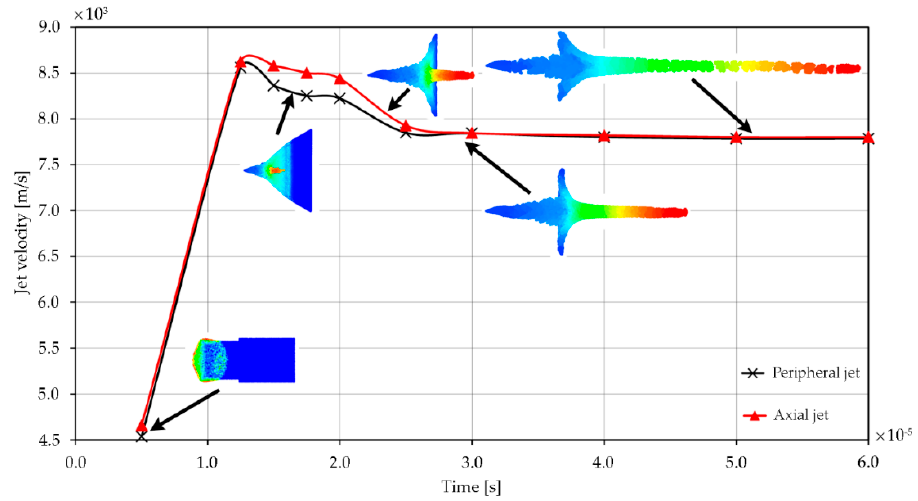
Figure 13. Jet velocities for two types of shaped charge.